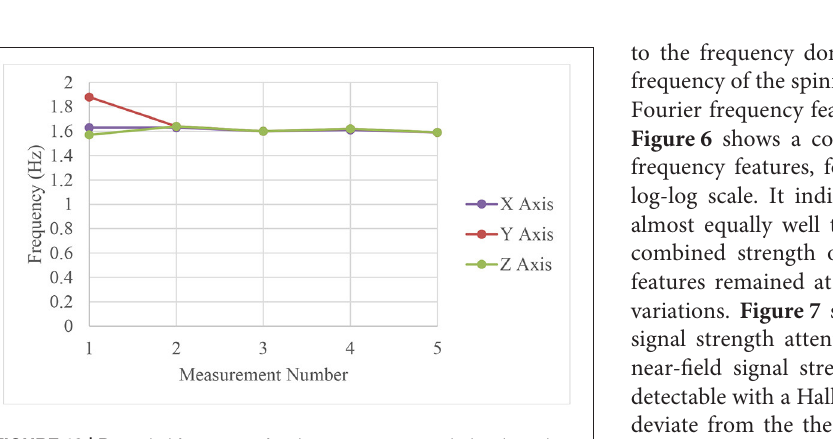
FIGURE 13 | Recorded frequency of moisture sensor transmission through concrete